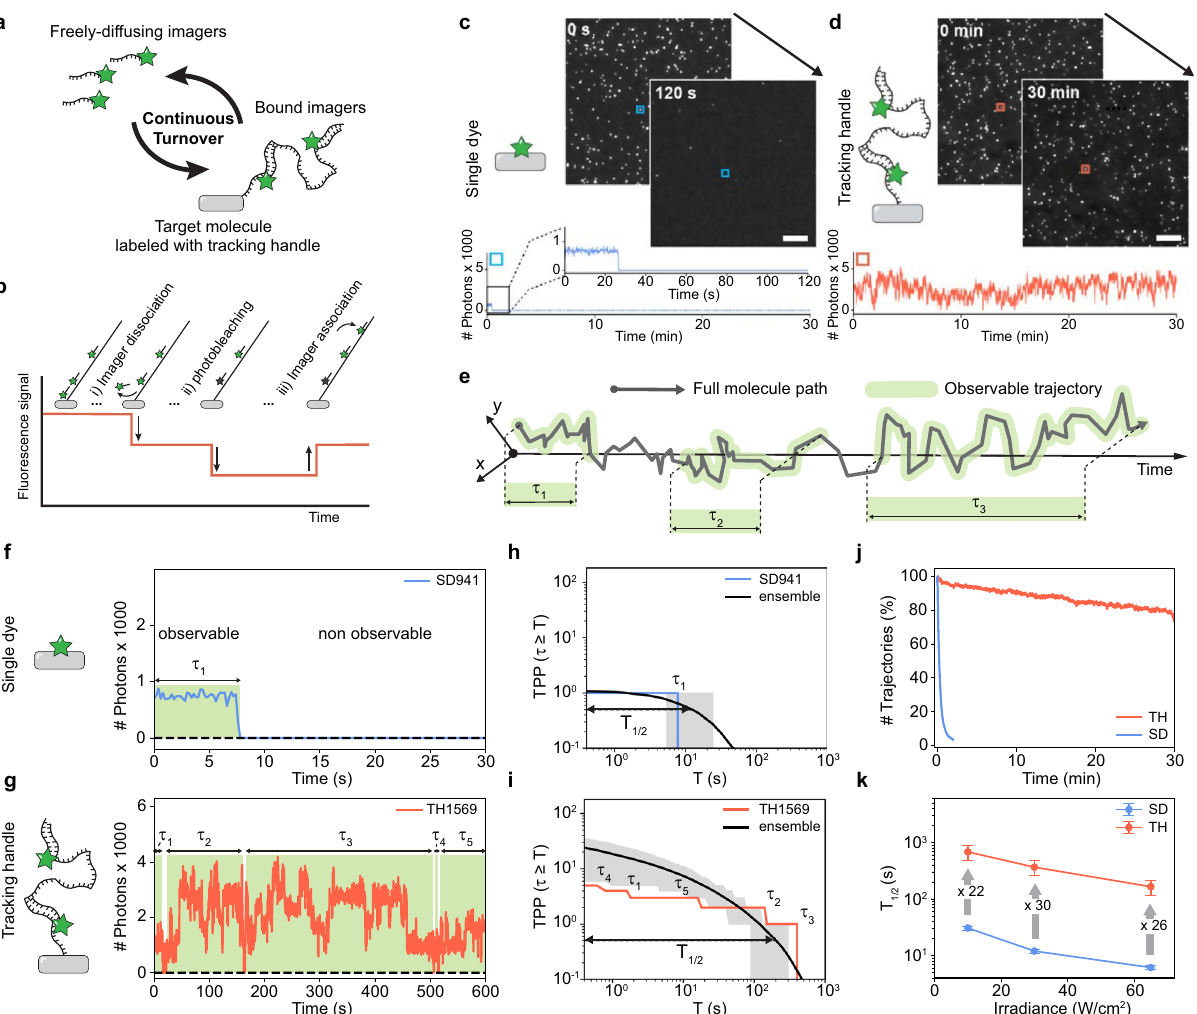
Fig. 1 DNA-mediated continuous fl uorophore exchange leads to long observations times for labeled molecules. a Principle of re-purposing DNA-PAINT for single-particle tracking experiments. Freely-diffusion imagers are binding and unbinding in a continuous turnover to the TH attached to the target molecule. b Schematic of intensity fl uctuations recorded from a TH caused by imager dissociation, association and photobleaching. c TIRFM imaging of static DNA origami labeled with single-dye (left) and fl uorescence traces corresponding to the marked particle. d Same as ( c ) but for TH origami under equal imaging conditions and 40 nM of imager in solution. e Distinction between full molecular path (x-y-t) and its observable sections by means of a detectable fl uorescence signal. This leads to the recording of a multitude of trajectories per particle of durations τ i . f SD example fl uorescence trace (SD941 arbitrarily selected out of all (cid:3) 3000 SD origami surpassing the fi lter criteria described in Supplementary Fig. 4). g Arbitrarily selected TH example fl uorescence trace (analogous to f ). h Plot of TPP τ (cid:5) T ð Þ vs. T for the SD fl uorescence trace in ( f ) (blue) and averaged over all SD origami in the data set (black). i Plot of TPP τ (cid:5) T ð Þ vs. T for the TH fl uorescence trace in ( g ) (orange) and averaged over all TH origami in the data set (black). j Number of trajectories per frame (i.e., emitting labels) vs. measurement time normalized to initial trajectory number. Total number of recorded trajectories: n (cid:3) 149,000 (TH) and n (cid:3) 3700 (SD) ( k ) T 1 = 2 vs. irradiance plots for SD origami (blue) and TH origami (orange) imaged at varying irradiances without using an oxygen scavenging system (after fi ltering, SD data sets contained at least n (cid:3) 3000 origami and TH data sets at least n (cid:3) 700 origami). Arrows indicates factors of increase of TH vs. SD. Scale bars, 5 μ m in ( c , d ). Error in ( h , i ) refers to interquartile range indicated as gray shaded area. Error bars in ( k ) correspond to relative standard deviation (see Supplementary Fig.